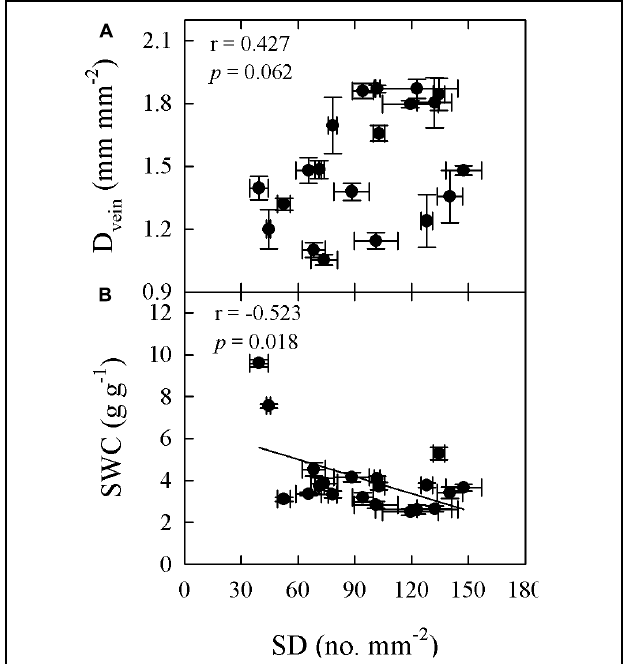
FIGURE 6 | Pearson’s correlations of SD with vein density (D vein ; A) and SWC (B) across 20 Cymbidium species.